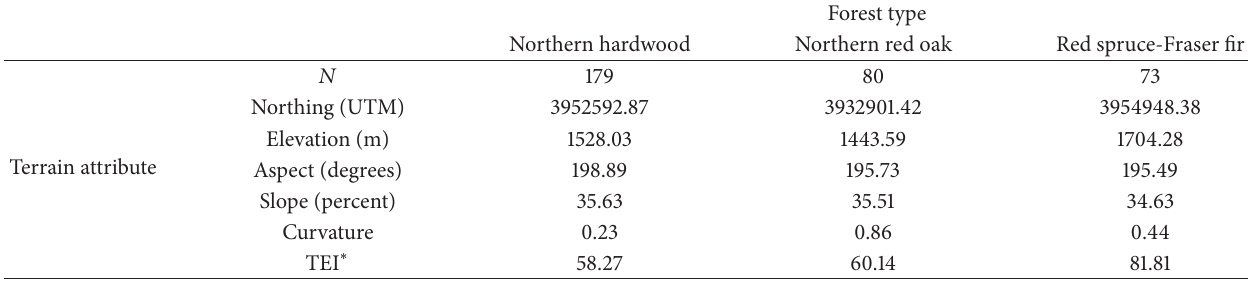
Table 1: Mean terrain attributes of the three forest types in the areas above 1219.2.2 m in elevation of western North Carolina, eastern Tennessee, and southwest Virginia which composed our study area ( 𝑛 = 332 ). Sampling took place between June 2012 and January